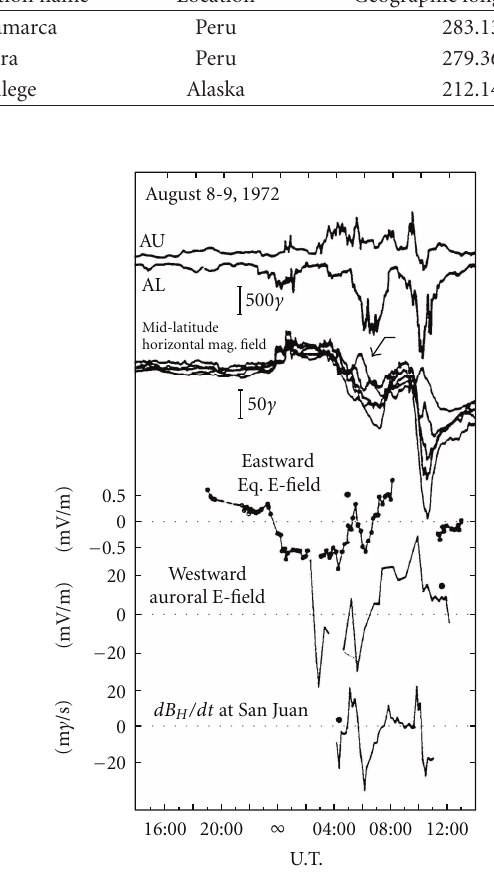
Figure 1: From top to bottom: The AU, AL indices; five super- posed midlatitude magnetograms (Kakioka, Tashkent, Tangerang, San Juan, Honolulu) with the arrow pointing to the San Juan magnetogram; the zonal electric field at the equator (Jicamarca, Peru); the auroral zonal electric field at College, Alaska; the time derivative of the horizontal component of the magnetic field at San Juan, Puerto Rico. In the last three panels, the dots indicate local magnetic midnight. (After [5]. Reproduced with permission of the American Geophysical Union).